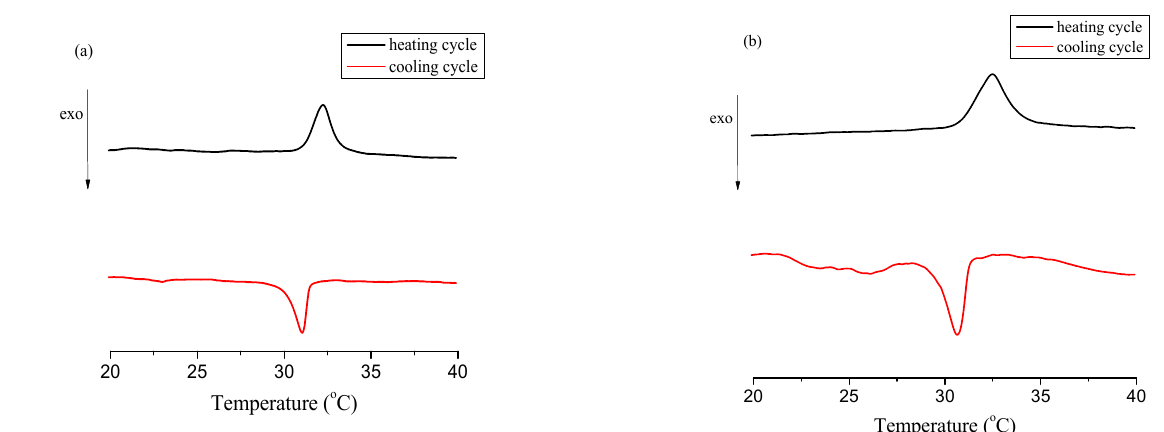
Figure A2. DSC thermograms of 5 wt % aqueous solutions of poly(N-isopropylacrylamide): ( a ) sample I and ( b ) sample II.